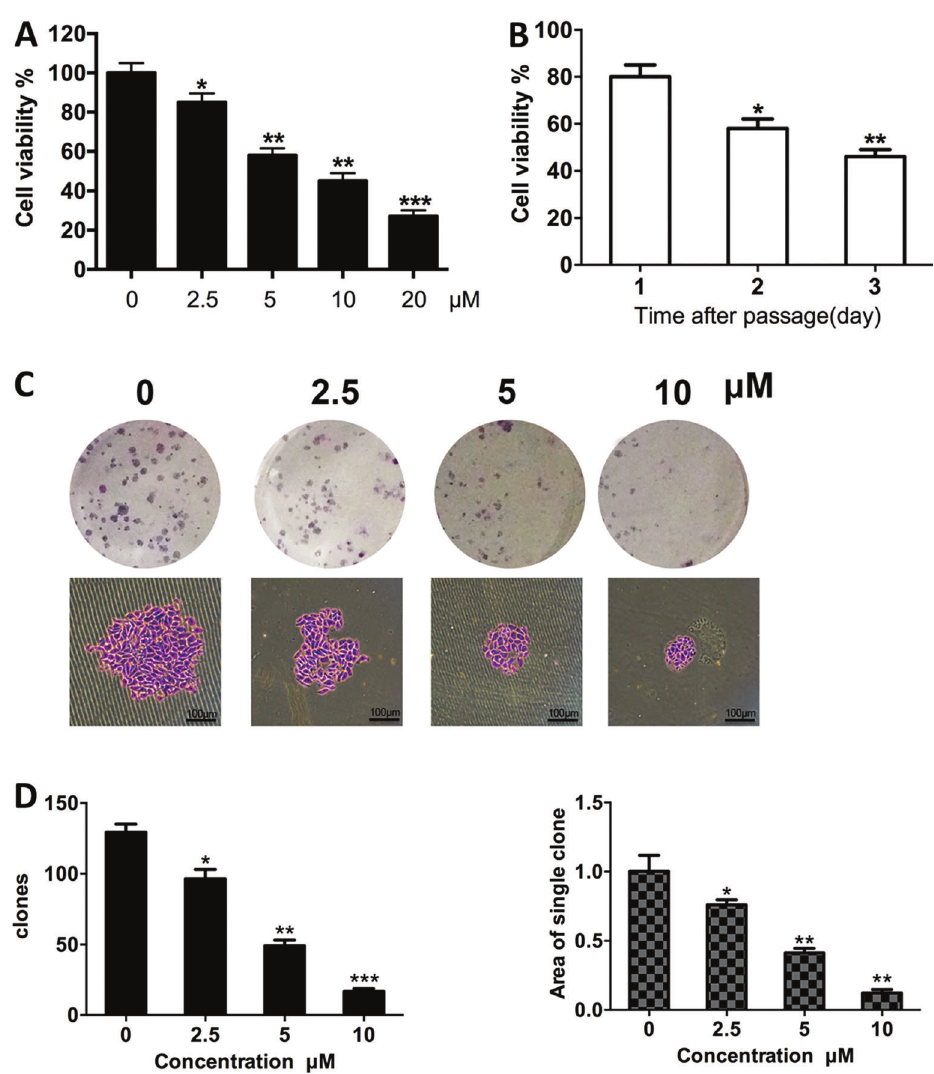
Figure 1. Cantharidin inhibited MDA-MB-231 cell growth in a dose- and time-dependent manner. A , MDA-MB-231 cells were assayed for cell viability determination with 2.5 – 20 m M cantharidin. Cells without cantharidin treatment were used as control. All groups of cells were cultured for 48 h. B , At a fi xed dose (5 m M), cantharidin inhibited MDA-MB-231 cell viability in a time-dependent manner. C , Colony formation assays were performed using MDA-MB-231 cells treated with indicated doses of cantharidin. The clones were stained with crystal violet. D , In the colony formation assay, formed clones were counted manually for each group of cells (left panel). The size of each clone was also calculated and averaged (right panel). Data are reported as means ± SD. *P o 0.05; **P 0.01; ***P o 0.001, compared to control ( t